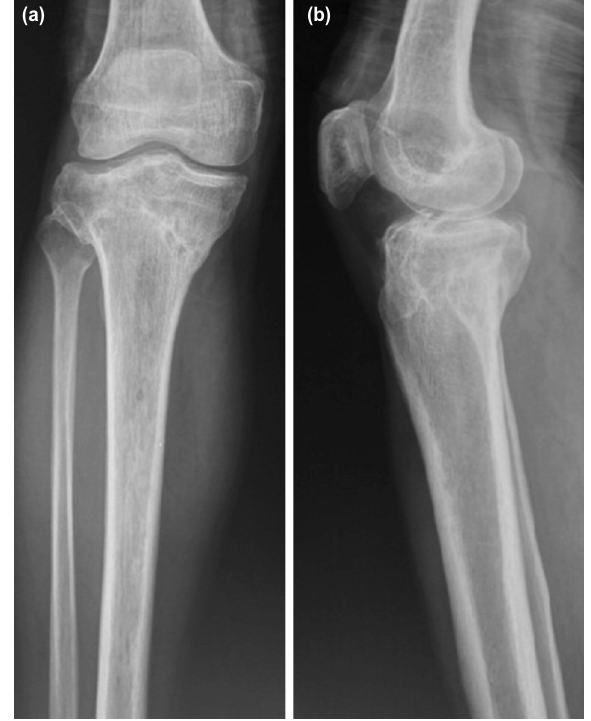
Case No.7, radiographs of knee at final follow up Fig. 9: showing fracture union and well-maintained alignment. (a) Antero-posterior view. (b) Lateral view.